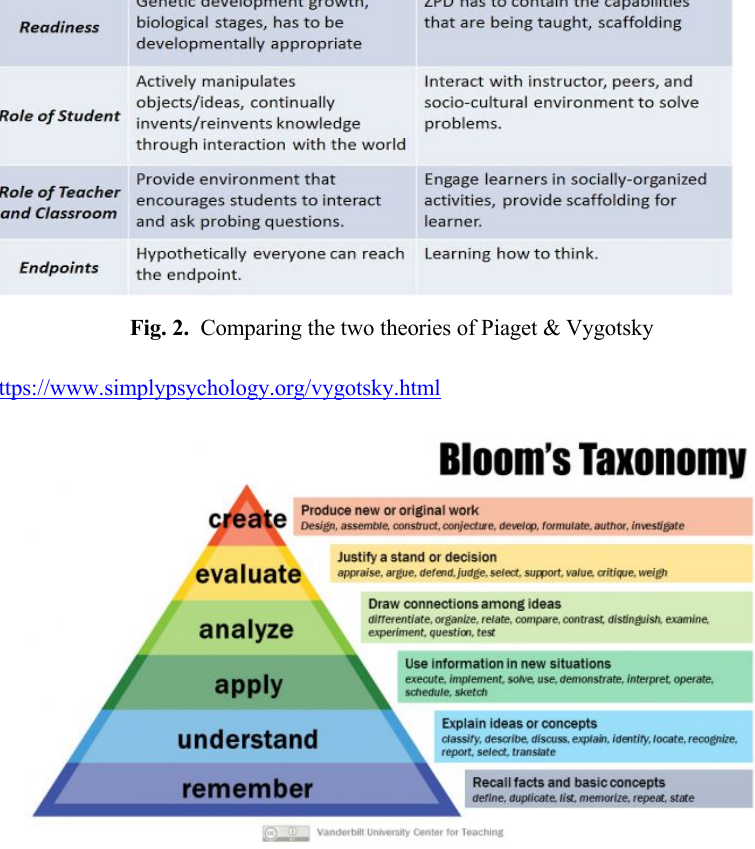
Fig. 3. Bloom’s Taxonomy of Learning